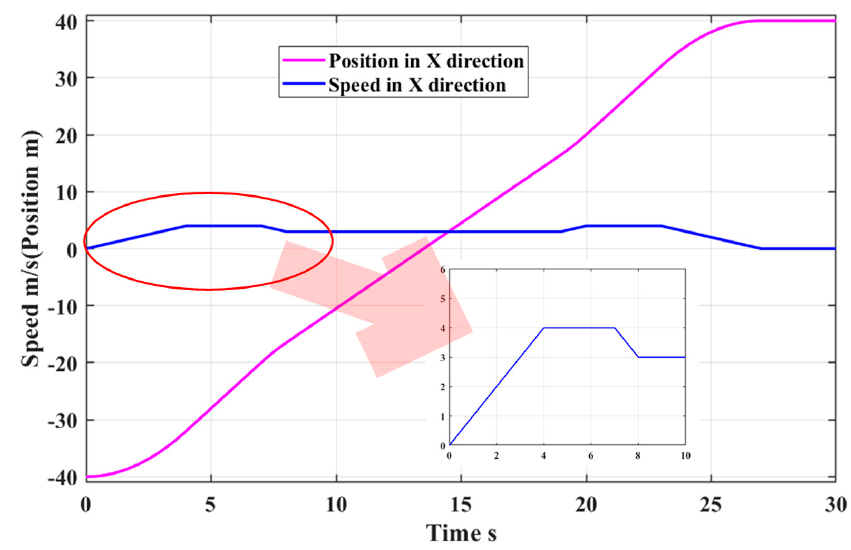
Figure 4. Desired path one for track-following servo control is plotted in this figure. The initial position of the CLRV is ( − 40, 0). Path one is the trajectory of the CLRV moving in the X -direction. The trajectory consists of uniform acceleration, uniform deceleration, uniform motion, and changes in X -directional speed due to uphill and downhill slopes.